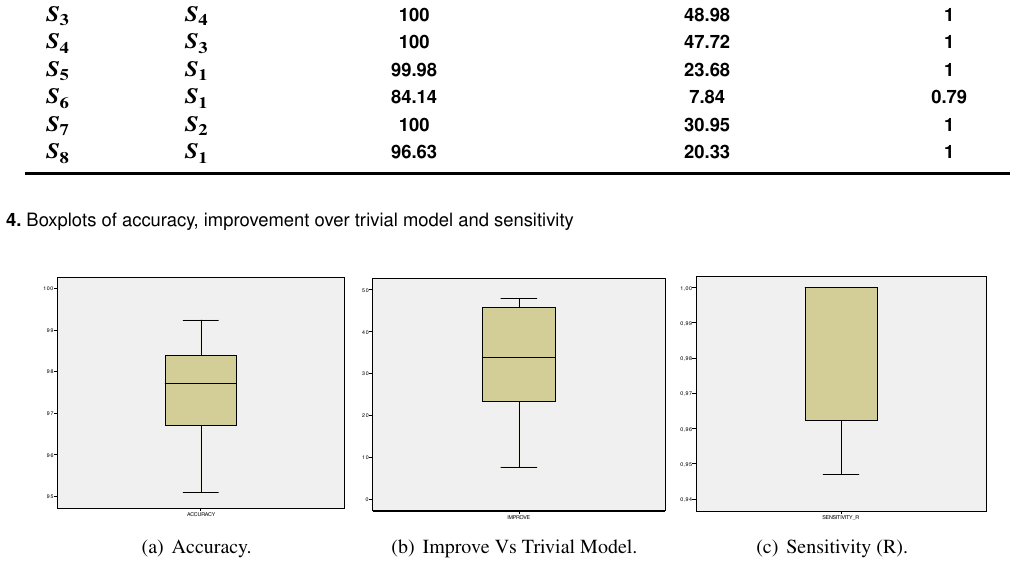
Fig. 5. Boxplots of resistance accuracy, resistance improvement over trivial model and resistance